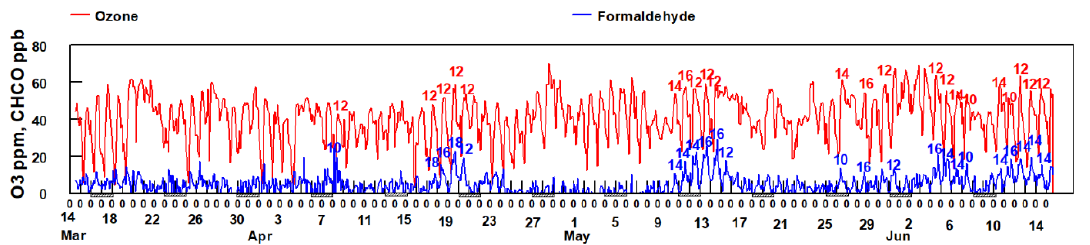
Figure 12. Comparison of O 3 and HCHO concentrations between March 14 and June 14. The hour of the day in which O 3 and HCHO peak are labeled for some of the observed peaks. The hash marks under the x -axis indicates weekends .